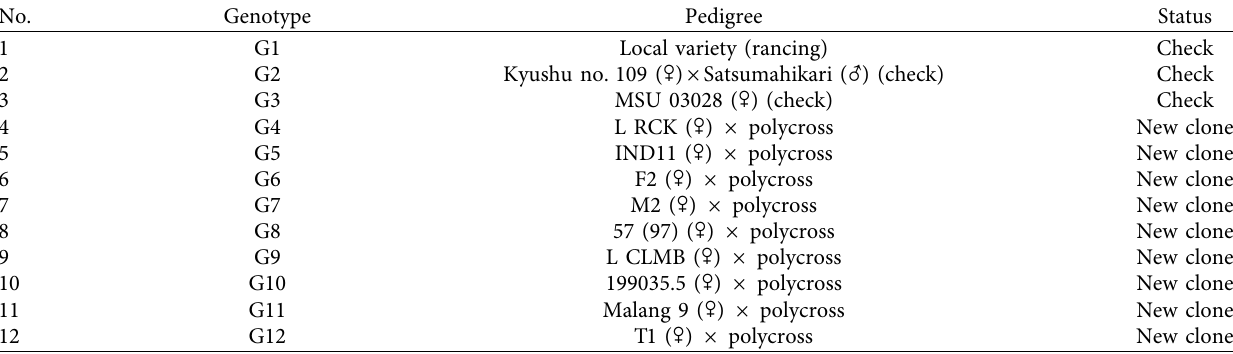
Table 1: Pedigree of 12 PFSP genotypes evaluated in the